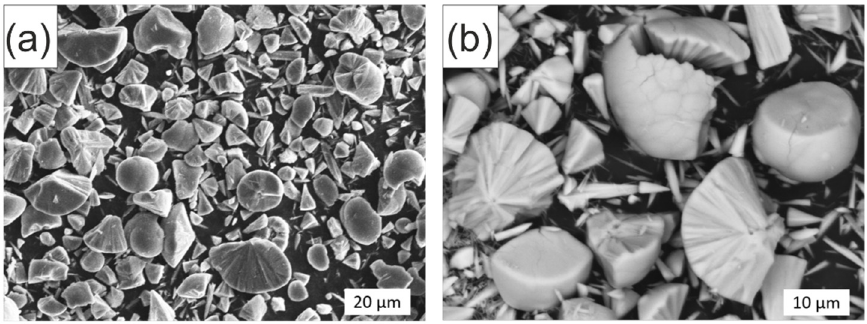
Figure 3. SEM images of rutile TiO 2 spherulites at different magnifications: 20 μ m ( a ), 10 μ m ( b ).